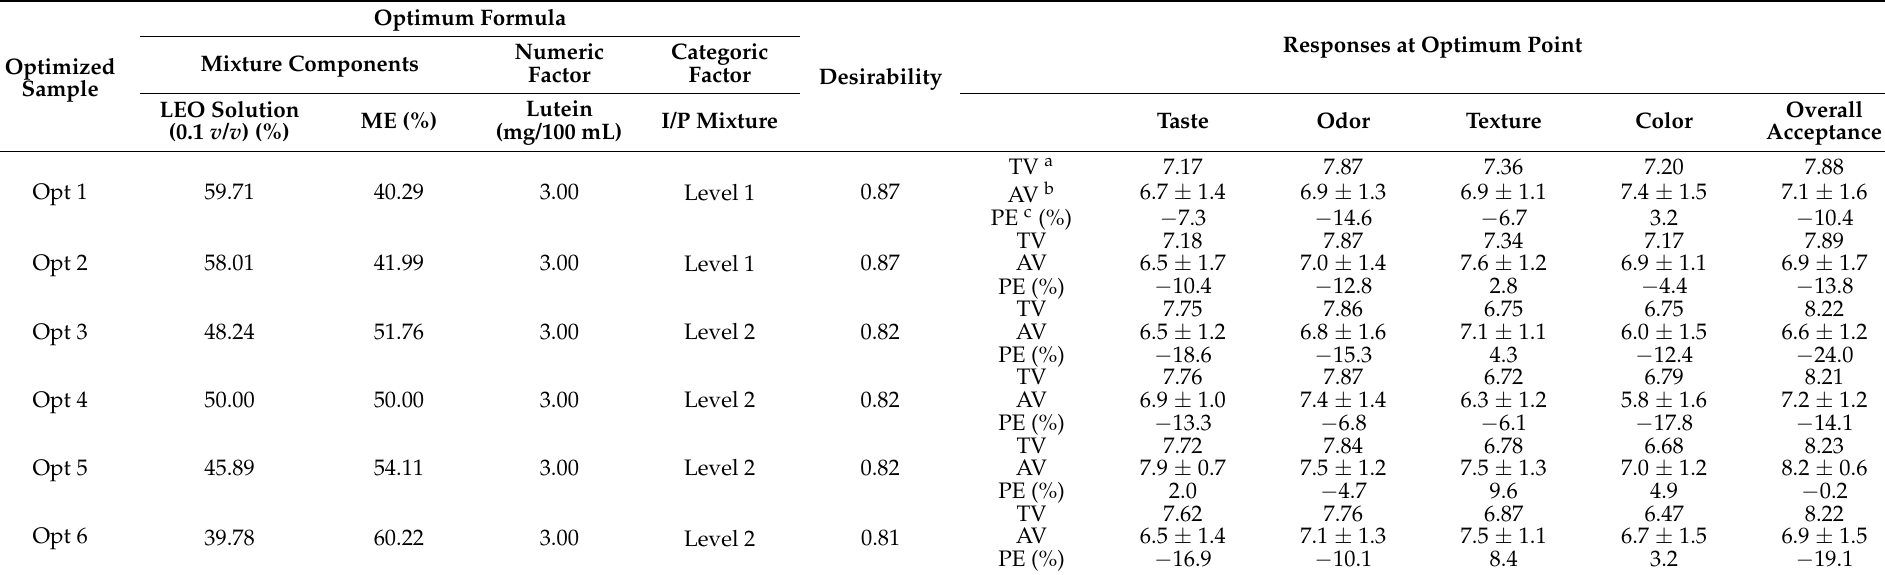
Table 4. Optimum points calculated using CD, desirability values, the actual and theoretical acceptance scores of responses obtained at the optimum points, and the percentage errors between these